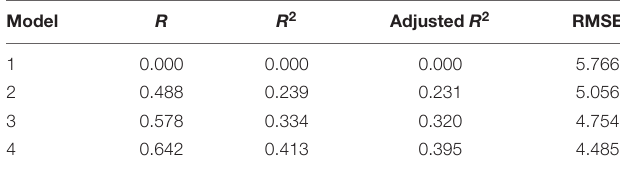
TABLE 4 | Model summary of text reading comprehension.